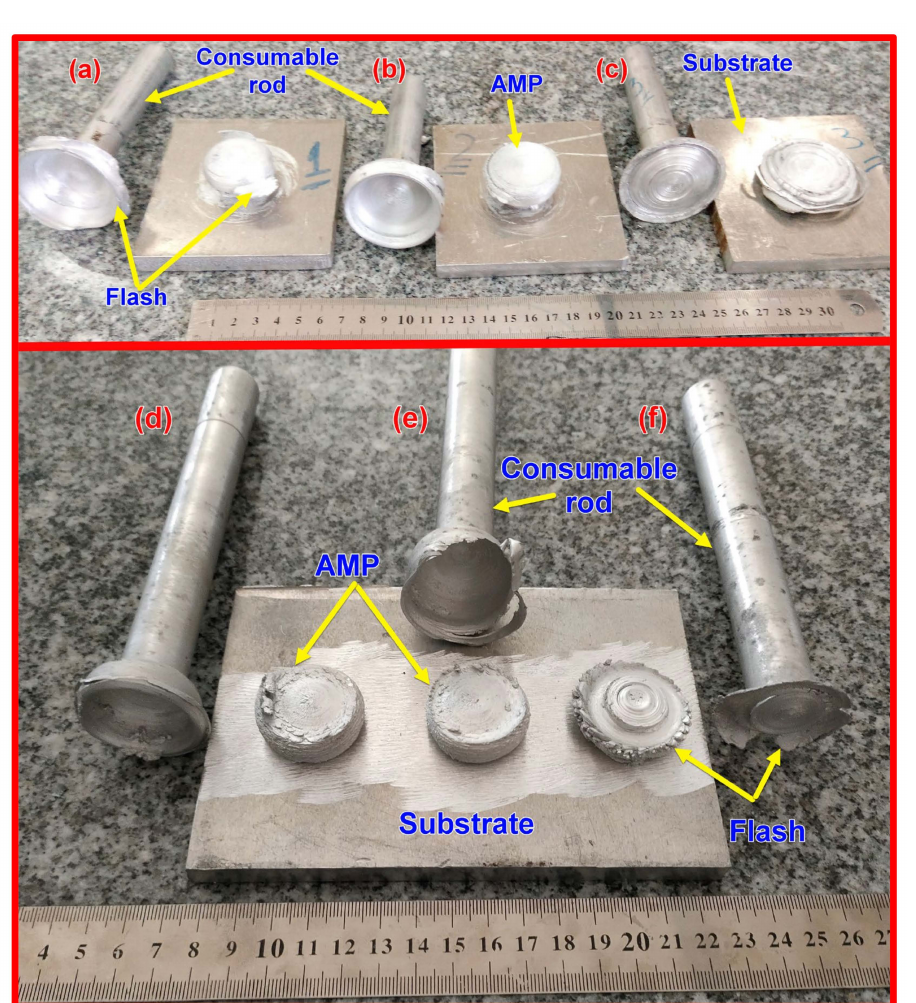
Figure 3. Optical images for the AMPs using FSD and their rods counterparts that remain after obtaining the required part length. AA2011-T6 AMPs processed at 1200 rpm and feeding speeds: ( a ) 3 mm/min, ( b ) 6 mm/min, and ( c ) 9 mm/min. The AA2011-O AMPs processed at 200 rpm and feeding speeds: ( d ) 1 mm/min, ( e ) 2 mm/min, and ( f ) 3